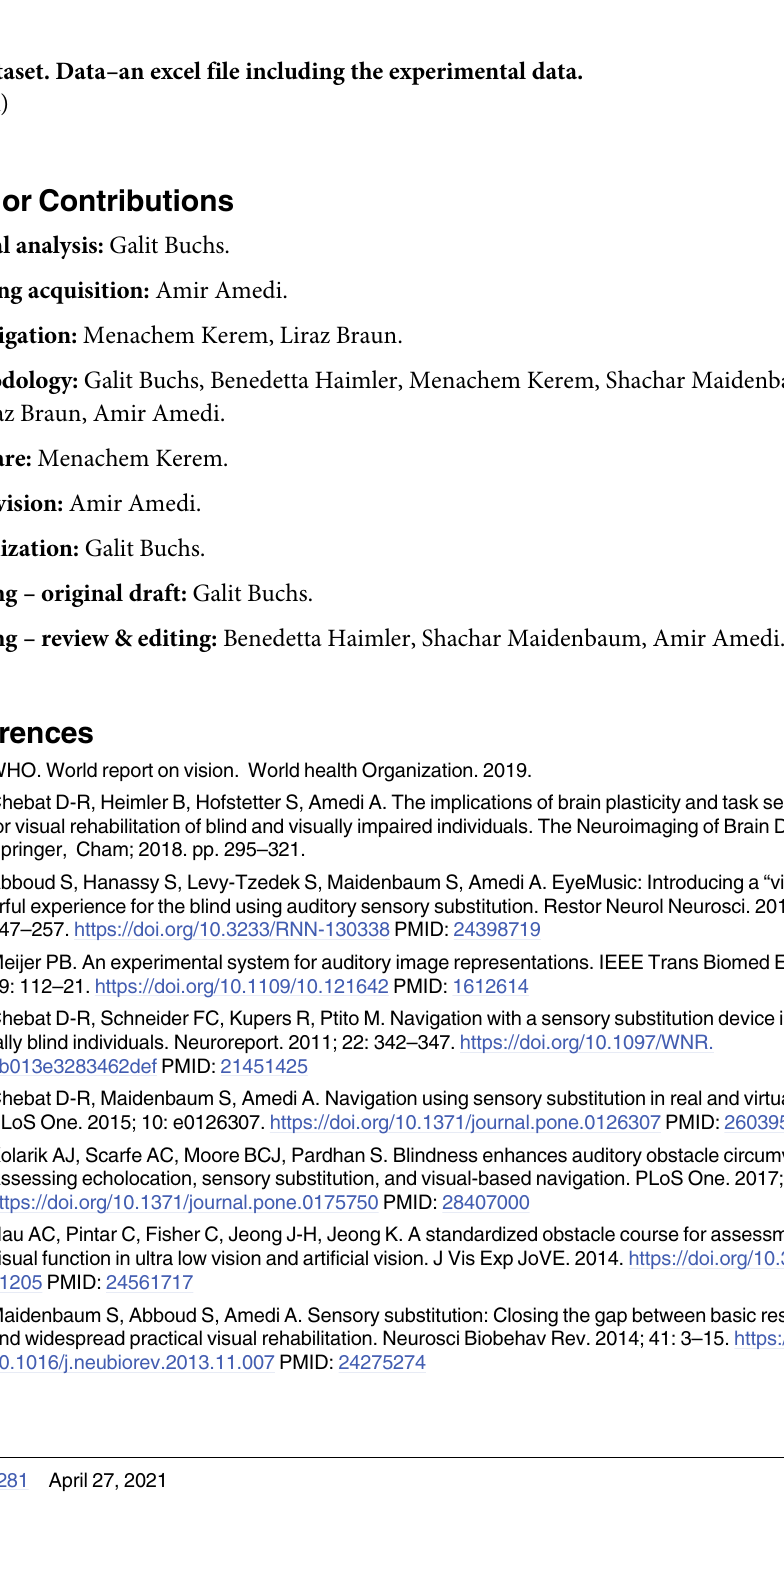
S1 Fig. Stimuli sample: Examples of the different stimuli presented in the different step- by-step lessons. S2 Fig. Pre-post training identification test–list of stimuli task, questions and the correct